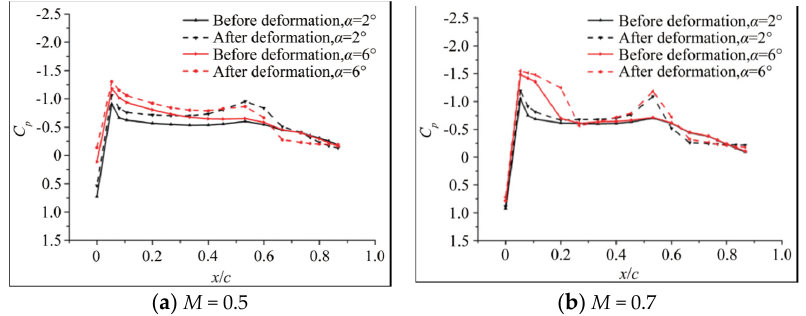
Figure 16. Effect of trailing edge deflection on pressure distribution over the model.